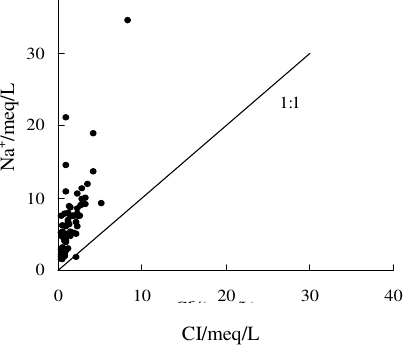
Figure 6. Relationship of γ Na + and γ Cl - in the study